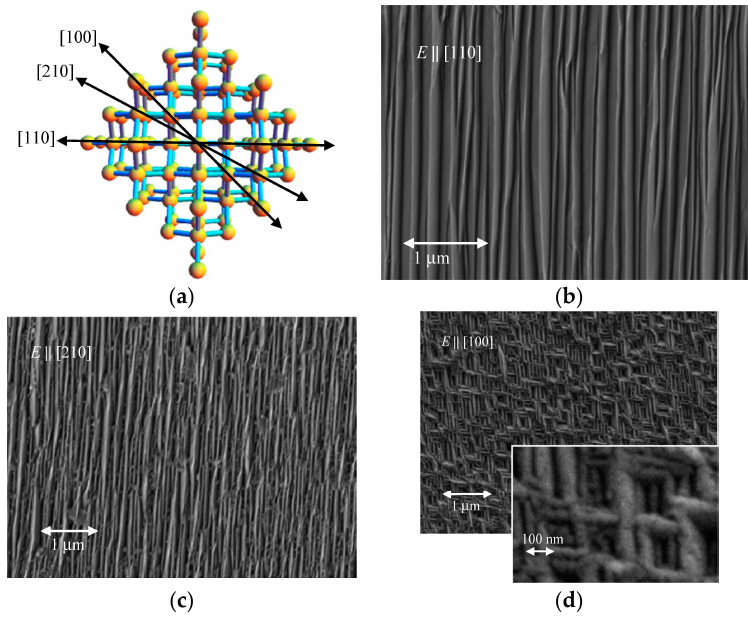
Figure 4. Patterning of the {001} diamond surface with two ‐ photon etching technique. ( a ) Lattice directions as viewed in the direction of the incident laser beam; ( b – d ) Scanning electron micrographs for a laser beam at normal incidence with polarizations parallel to [110], [210] and [100]. In each case the laser dose was 10.3 MJ/cm 2 , and the average depth of material removed was 550 nm [54]. (Copyright 2014 Macmillan Publishers Ltd.).